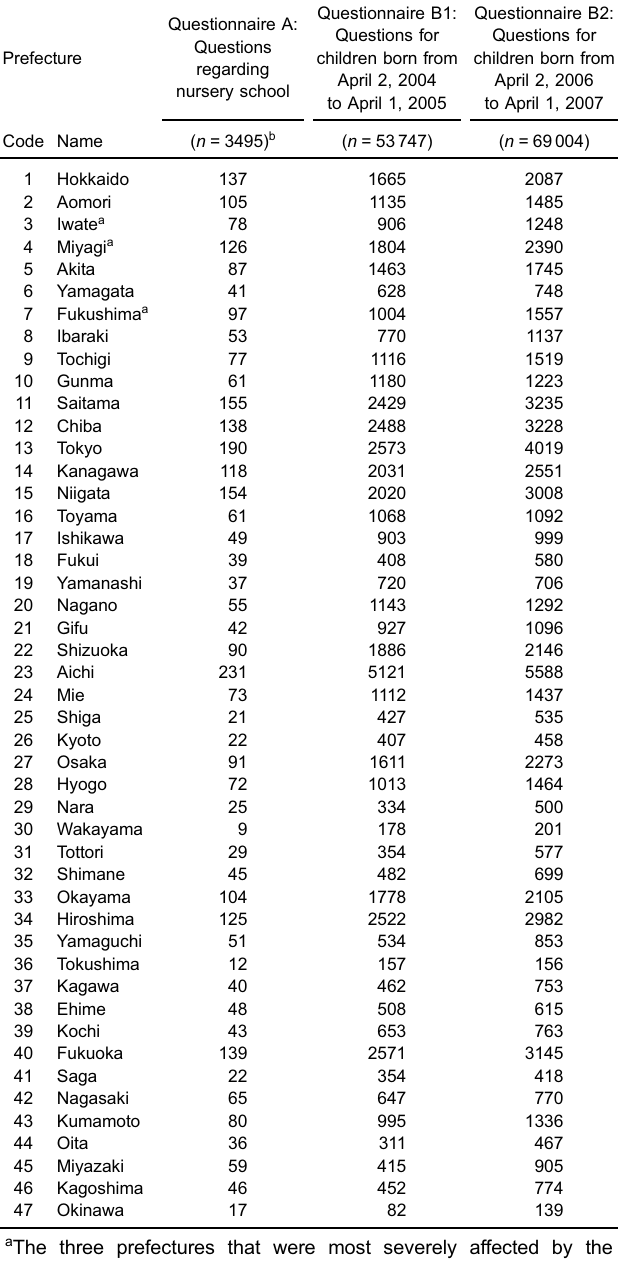
Table 2. Number of completed questionnaires returned from nursery Proportion